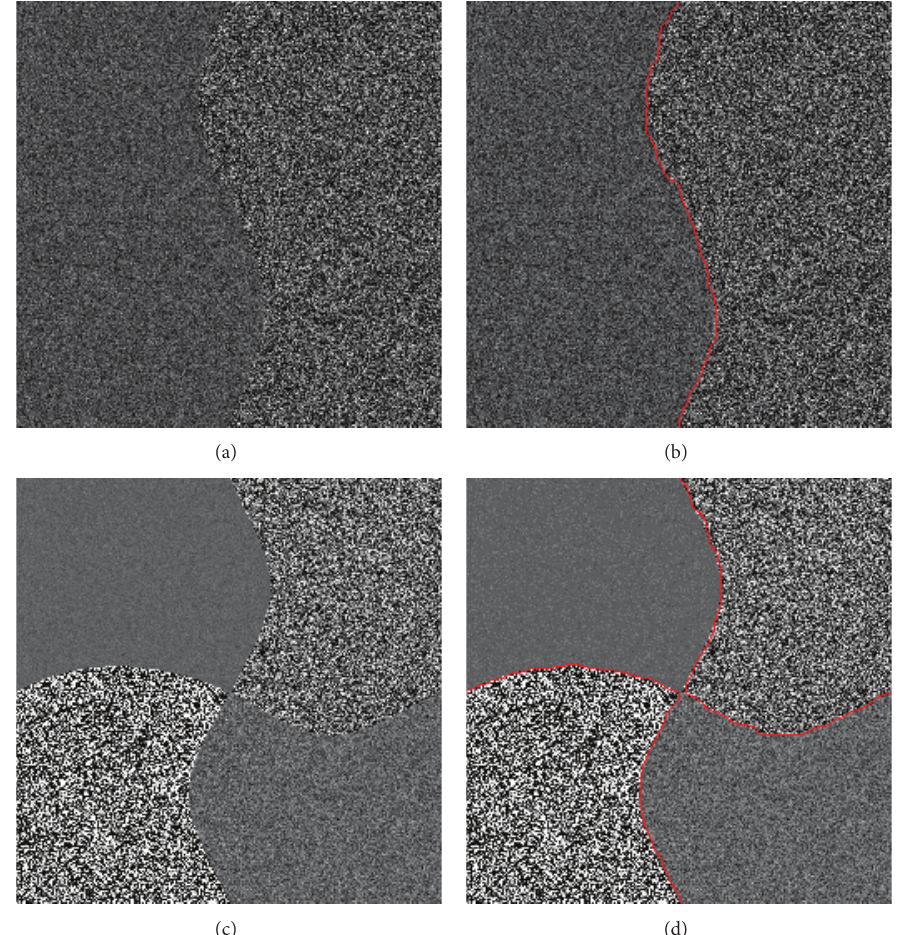
Figure 7: Images with different noise level for segmentation: (a) original image, (b) the segmentation result, (c) original image, and (d) the segmentation